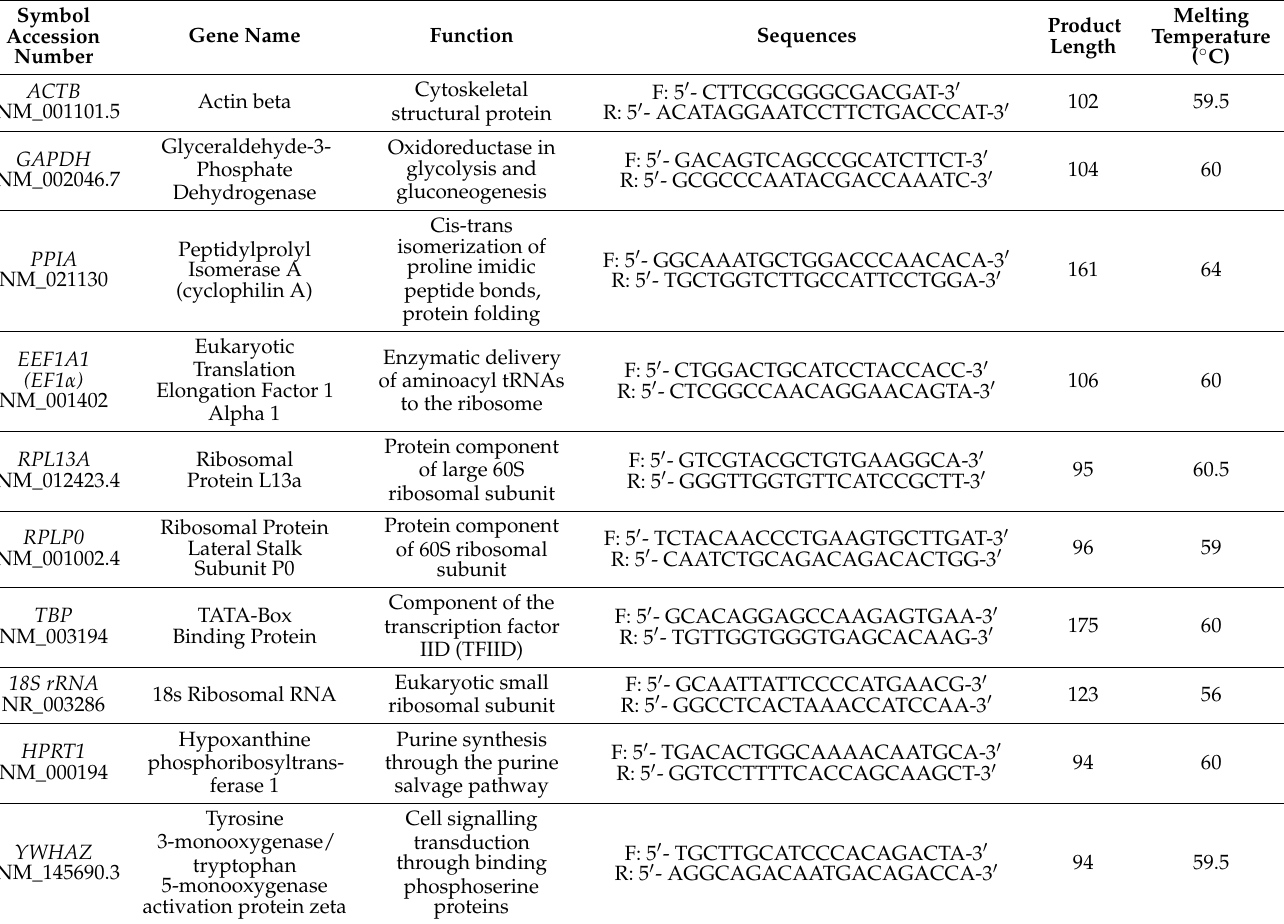
Table 1. Reference genes and their function and primer sequences used in this study.